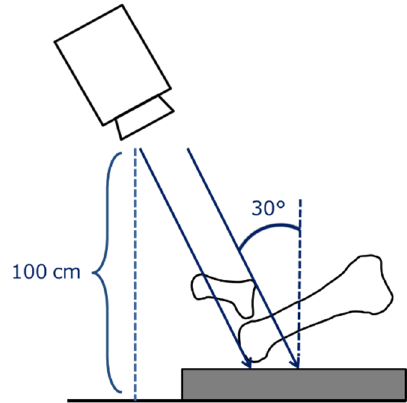
Figure 1. Method of plain radiography. Irradiation was performed from 100 cm and tilted forward by 30° from the vertical direction.